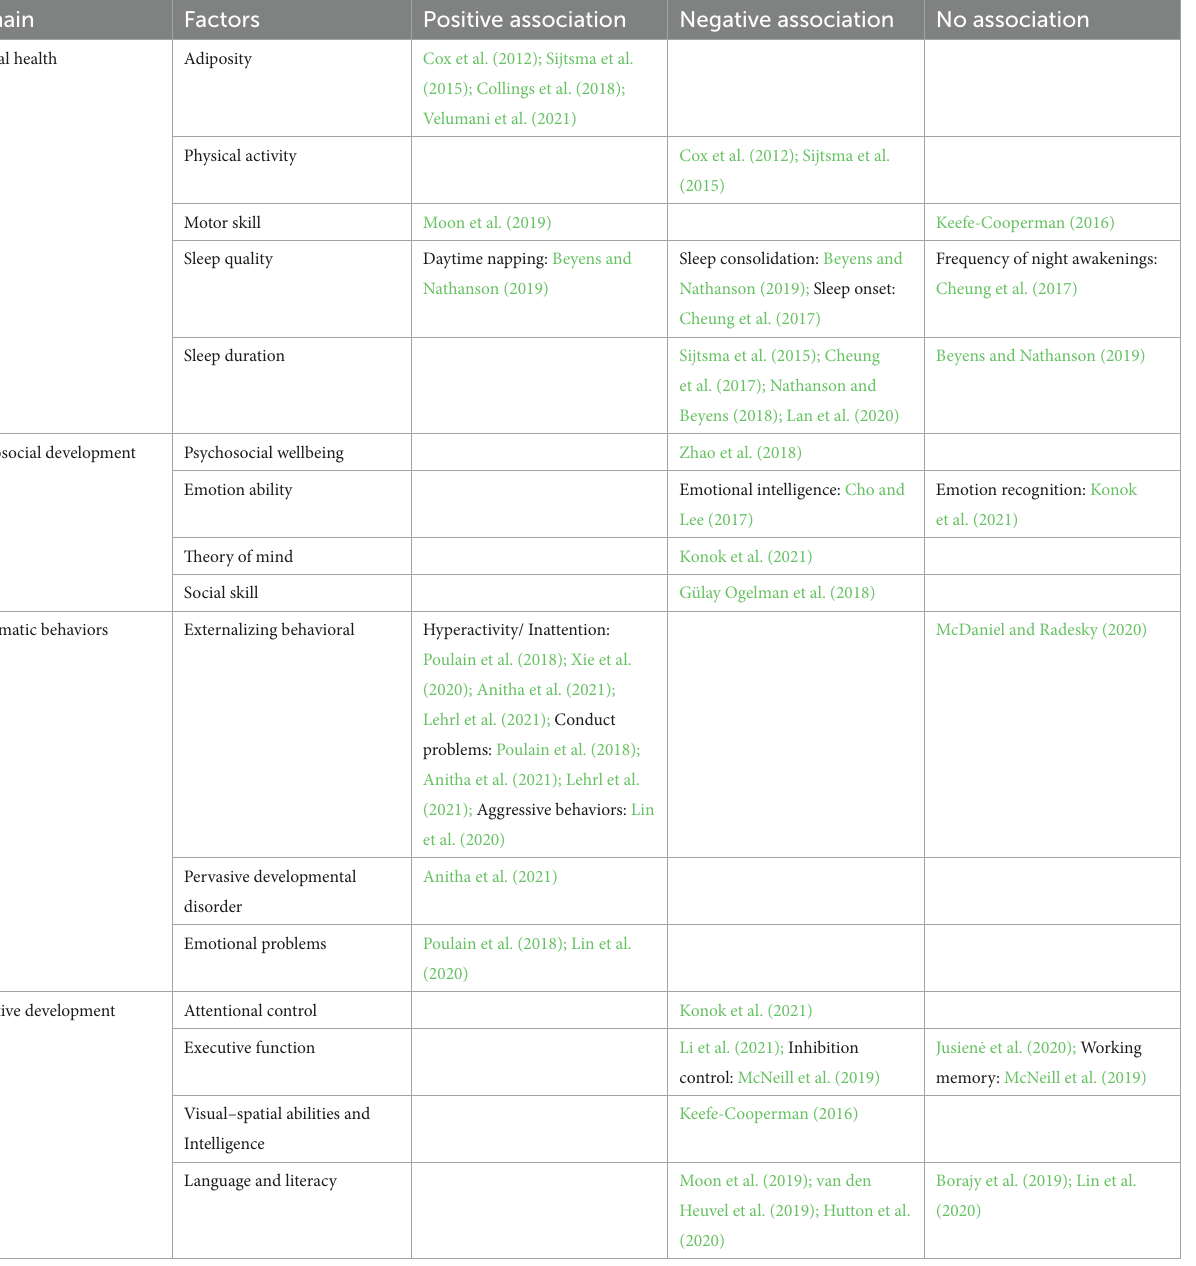
TABLE 4 Findings for the outcomes associated with young digital